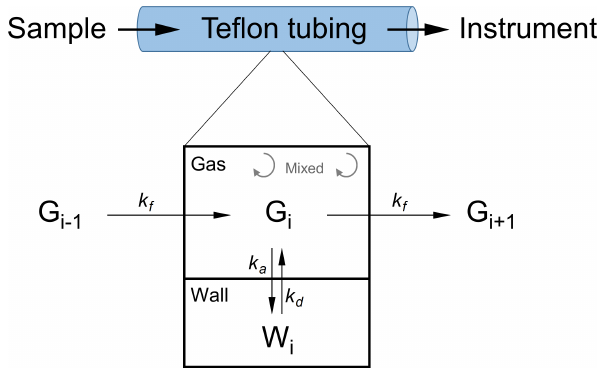
Figure 1. Schematic of the chromatography model used to describe delays caused by gas–wall partitioning of organic compounds in Teflon tubing. Compounds flow through a series of perfectly mixed bins, undergoing gas–wall partitioning within each bin. The rates constants for flow between bins ( k f ) , absorption ( k a ) , and desorption ( k d ) are dependent on tubing diameter, flow rate, and the saturation vapor concentration c ∗ of the compound being